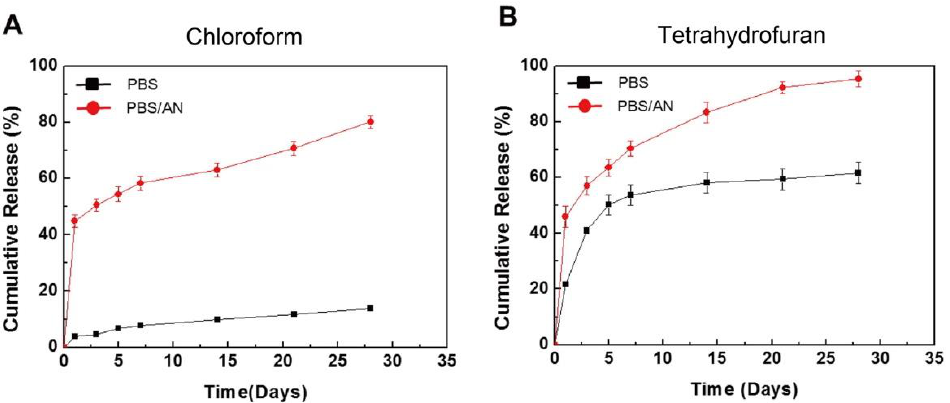
Figure 6. In vitro cumulative release of sirolimus from poly-D,L-lactic acid (PDLLA) layers in phosphate buffered saline (PBS) or PBS with acetonitrile (AN), prepared using an ultrasonic spray-coating system with ( A ) chloroform or ( B ) tetrahydrofuran. Adapted with permission from [52]; published by Elsevier, 2017.